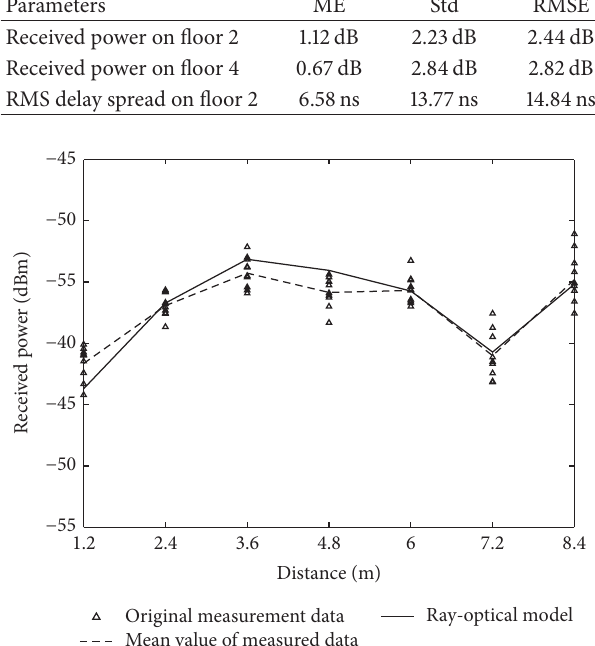
Figure 9: Received power versus link distance derived from ray- optical model and measurements on floor